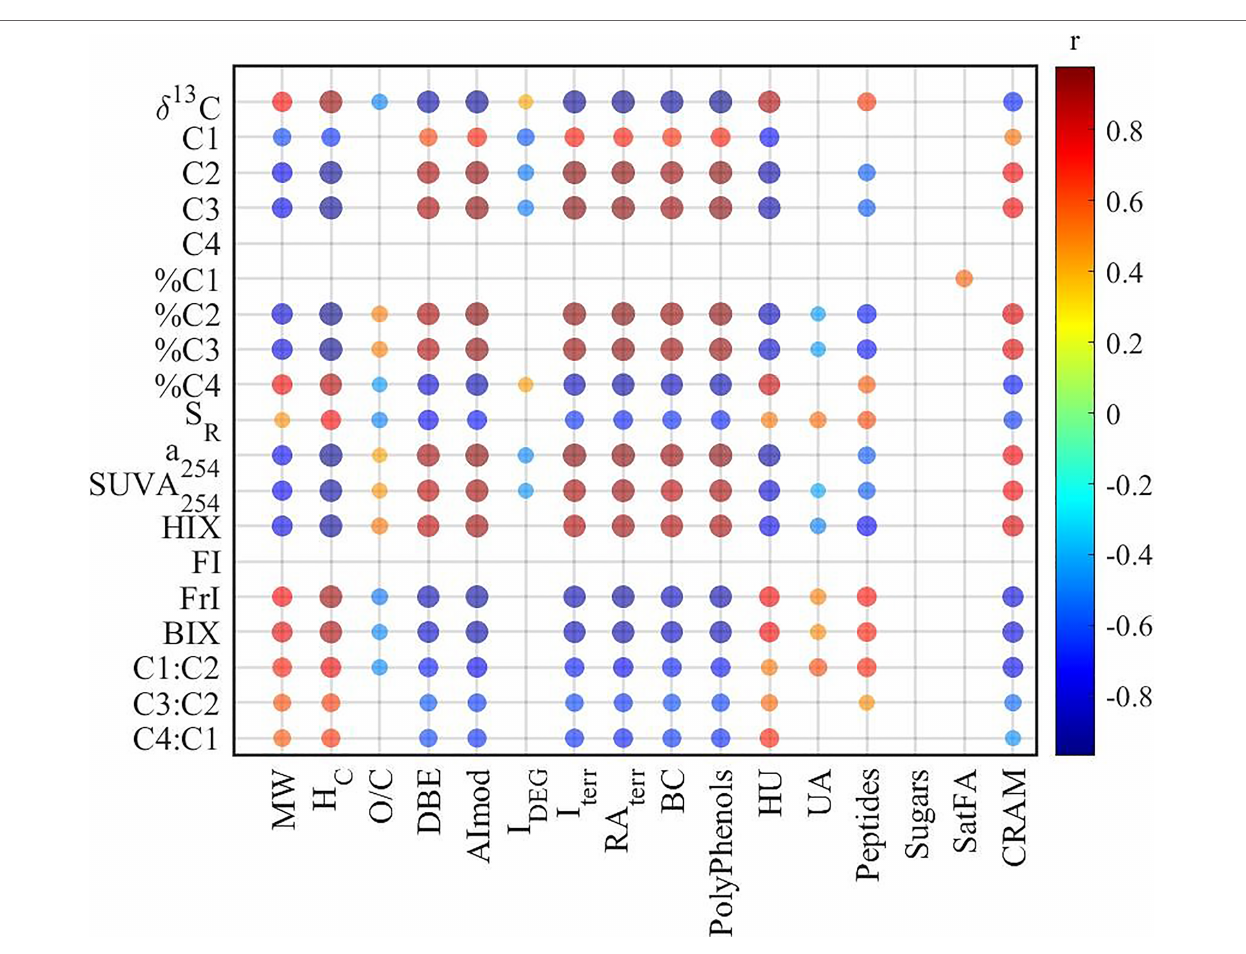
FIGURE 3 | Correlations (Pearson) among different isotopic and optical